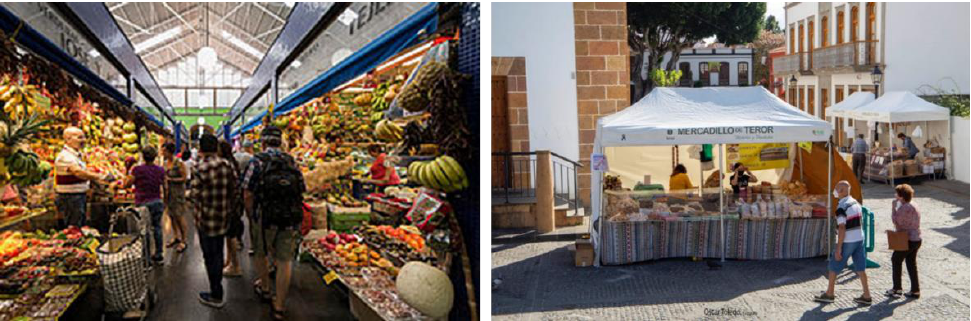
Figure 1. Street markets of Canary Islands.